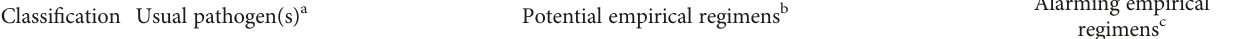
Table 3: Potential and alarming empirical regimens for di ff erent Wagner ’ s grades, IDSA/IWGDF grades, and types of diabetic foot infections. Classi fi cation Usual pathogen(s)